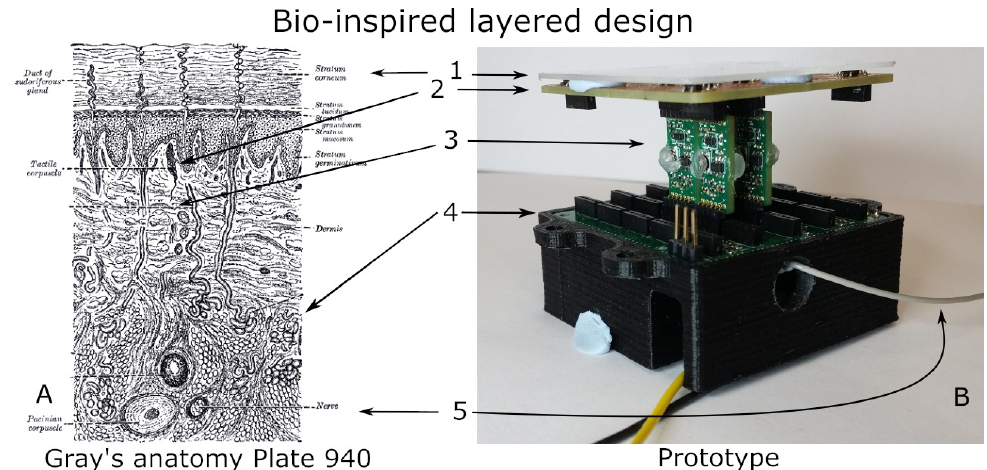
Figure 1. The image presents an illustration of the skin cross section ( A ) and side view of the prototype ( B ) layered structure. ( A ) Henry Vandyke Carter—Plate 940, Gray’s Anatomy: Descriptive and Surgical book [9] (Wikimedia image—public domain—some labels have been removed for clarity). ( 1 ) Outer skin interface; ( 2 ) sensors/nerve endings; ( 3 ) axons and encoding structures; ( 4 ) substrate/mixing signal and ( 5 ) nerves/main